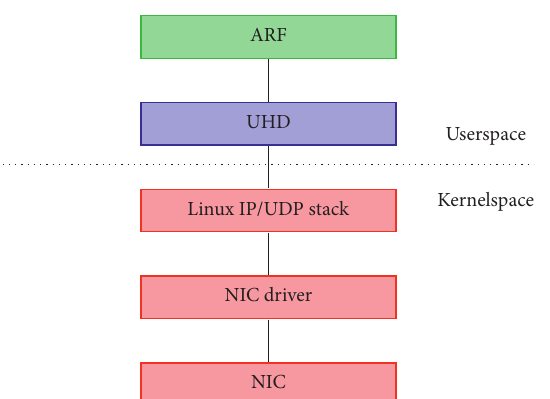
Figure 1: High-level overview of base station functions.